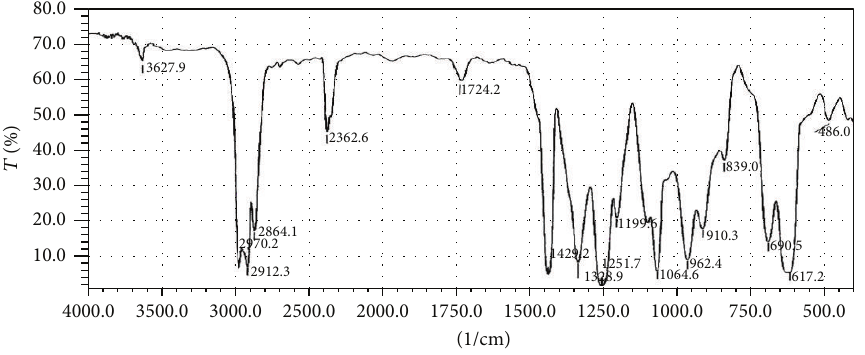
Figure 1: FTIR spectrum of PVC film (control) (30 𝜇 m) at zero time.